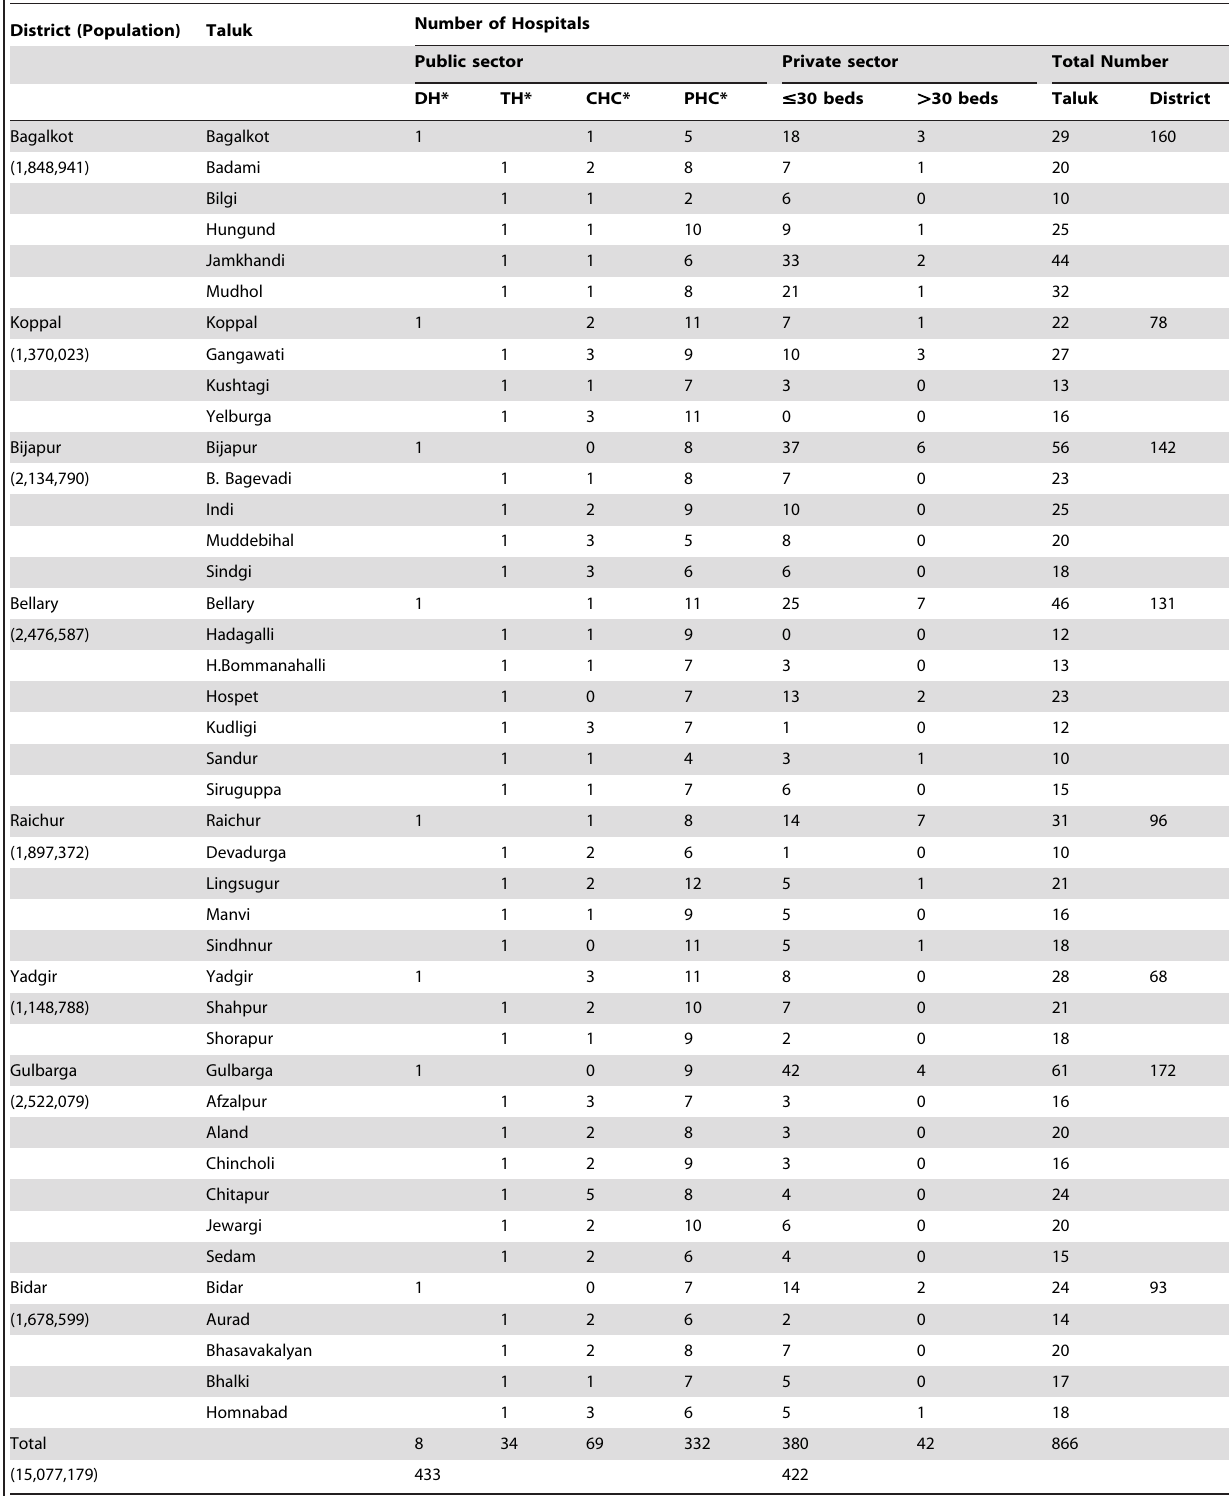
District (Population)